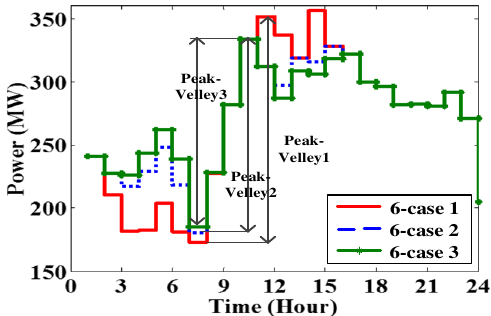
Fig. 8 Comparisons of difference of peak to valley of 6-bus